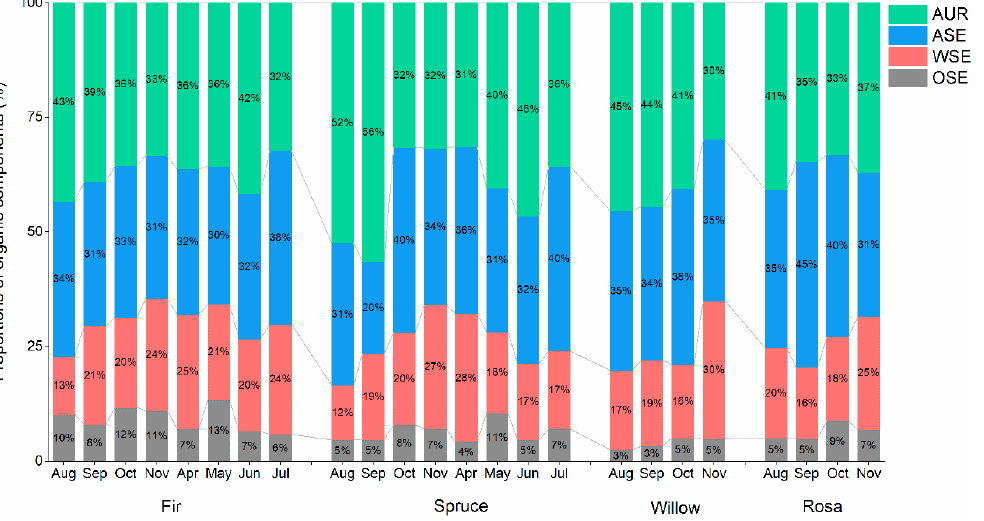
Figure 1. Monthly dynamics of the proportions of organic components (%) (WSE: water-soluble extractives; OSE: organic-soluble extractives; ASE: acid-soluble extractives; AUR: acid-unhydrolyzable residues) in newly shed foliar litter determined via proximate C fraction analysis. Table 1. Properties of the C quality of newly shed foliar litter for each plant species. Different low- ercase letters indicate significant ( p < 0.05) differences among the various plant species for each C quality aspect (plant species: fir, spruce, willow and rosa; functional C groups: aliphatic C, methoxyl C, O-alkyl C, di-O-alkyl C, aromatic C, phenolic C and carboxyl C; organic components: WSE, water- soluble extractives, OSE, organic-soluble extractives, ASE, acid-soluble extractives, AUR, acid-un- hydrolyzable residues; HB/HI, (0–45 ppm + 110–165 ppm)/(45–110 ppm + 165–190 ppm), and A/O- A, aliphatic C/O-alkyl C)).